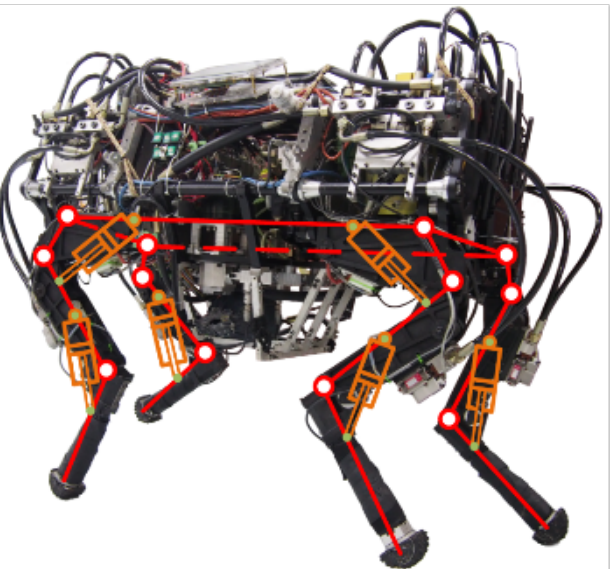
Figure 1. Hydraulic quadruped robot platform with multiple non-modelable hydraulic hoses and hydraulic drive units. This work consider the leg link with a hydraulic actuator as a single rigid body. The red lines indicate the general dynamics model of floating-based multiple rigid body. Reprinted with permission from ref. [28] 2022 IEEE